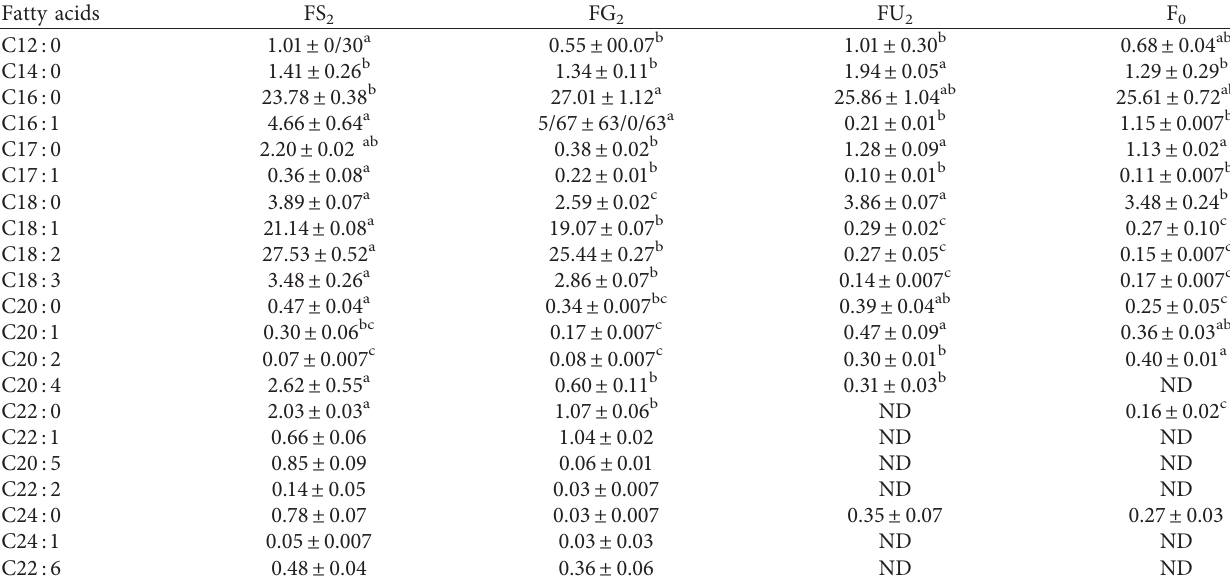
Table 3: Fatty acid profile of sour fruit samples with 3% algae